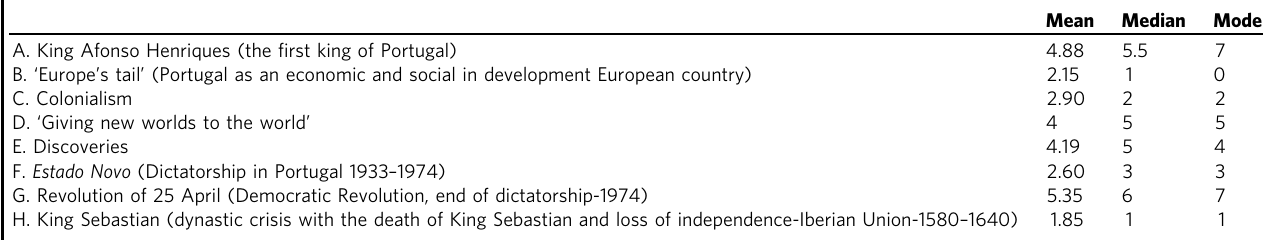
Table 8 Descriptive statistical measurements summary regarding to the question 5 ‘ The abbreviated narratives with the most signi fi cance for the History of Portugal are: ’ .